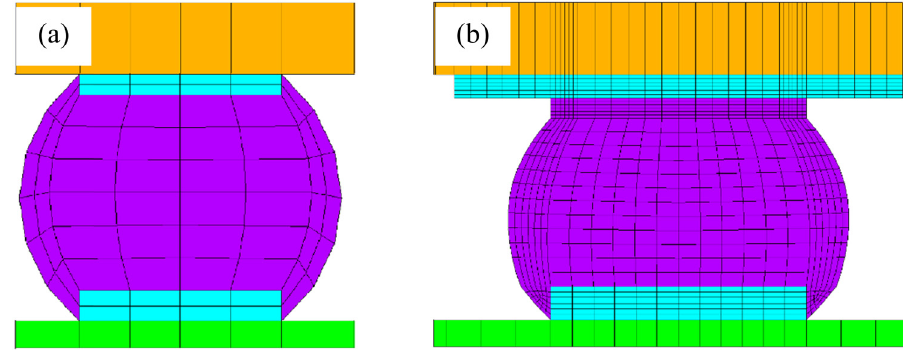
Figure 3: Solder joint used in ( a ) global model and ( b ) local model.